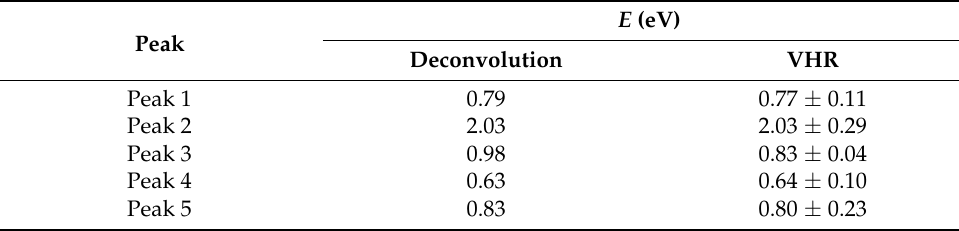
Figure 11. Results from VHR method obtained for PPG glass samples for three different heating rates of 0.5, 1.0, and 2.0 °C/s. of 0.5, 1.0, and 2.0 ◦ C/s. Table 6. Comparison of energies of trapping centers present in PPG glass sample. Table 6. Comparison of energies of trapping centers present in PPG glass